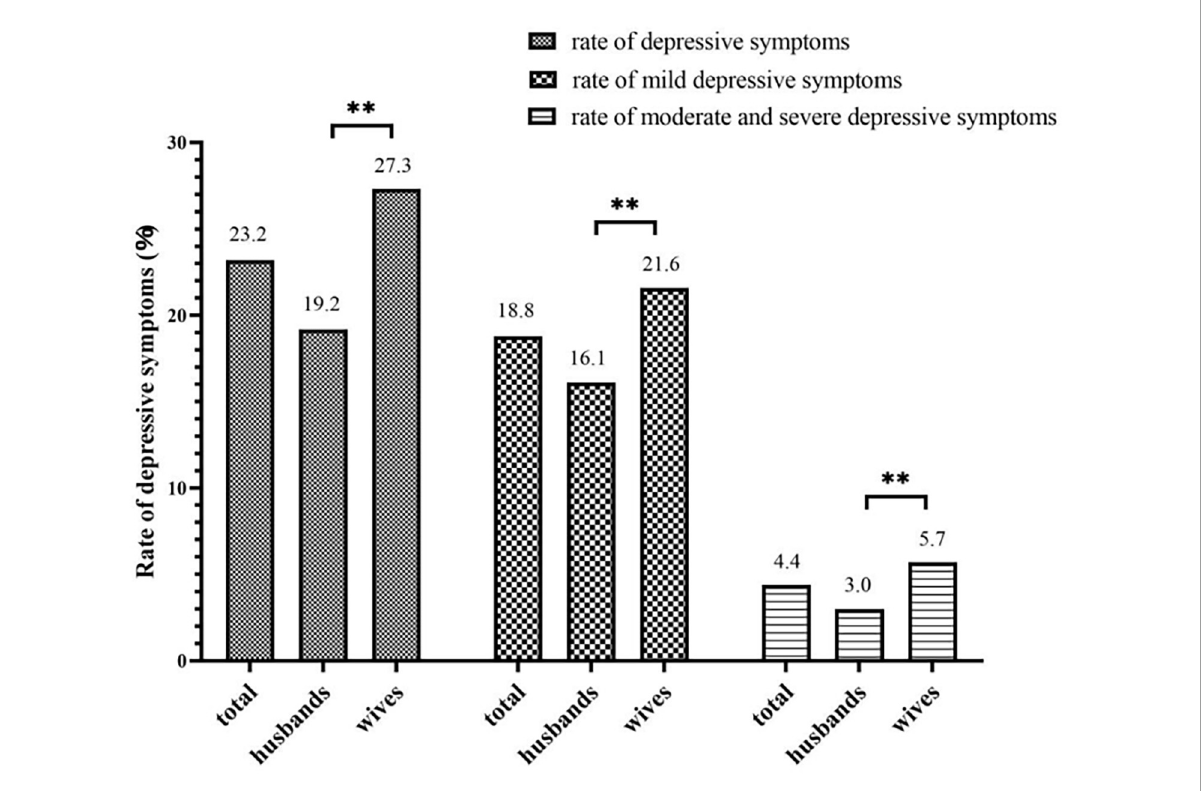
FIGURE3 Gender differences in the detection rate of depressive symptoms. ** P <